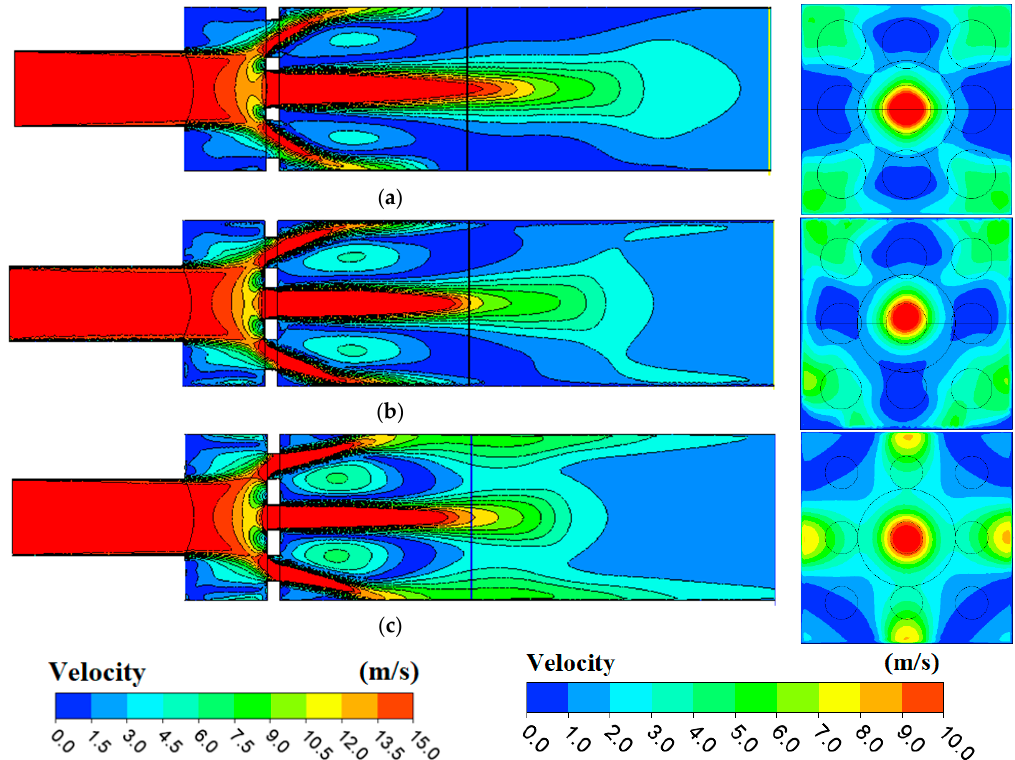
Figure 15. Velocity contours at the longitudinal section and cross-section ( Δ L = 150 mm) for three kinds of hole diameters, ( a ) Φ d = 30 mm, ( b ) Φ d = 25 mm, and ( c ) Φ d = 20 mm. The thermo-hydraulic performance of the DF-PCHE channels with three kinds of hole diameter 3 × 3 SPBs using Δ L =150 mm cross-section as inlets are shown in Table 4. The results show that, the α values for Φ d = 30 and 25 mm are nearly the same, which is obviously better than Φ d = 20 mm. Besides, the thermal--hydraulic performance ( h and